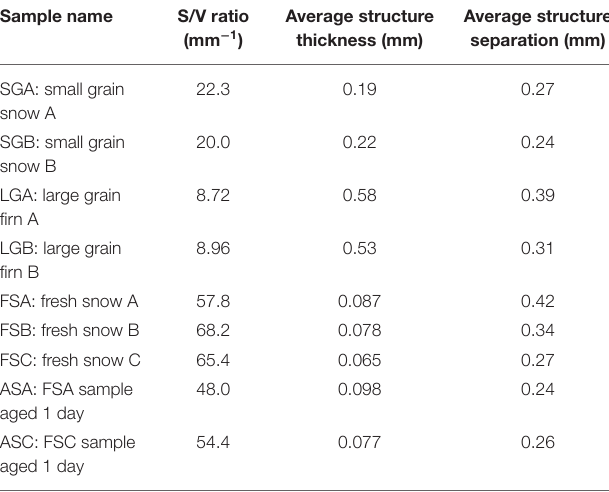
distinct classes: (1) Very thin “needles” with most structures < 0.1 mm thick for fresh snow (0.08 mm snow aged 1 day (0.09 mm Gaussian distribution of thicknesses centered roughly around 0.2 mm for small grain snow (0.21 mm